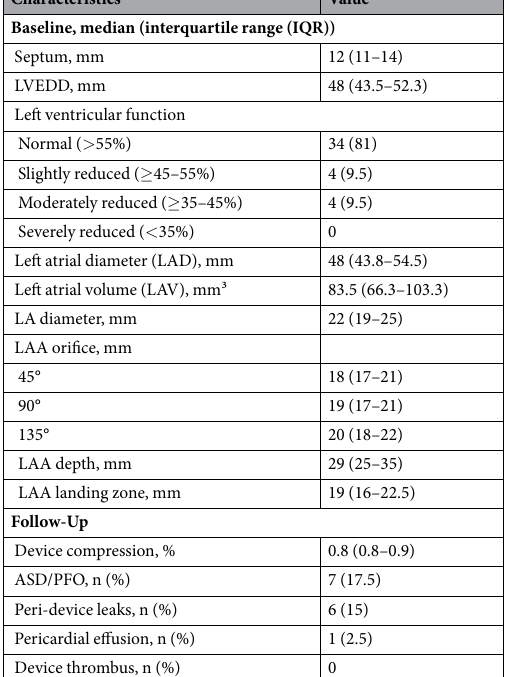
Table 3. Trans-esophageal echocardiography data at baseline (T1) and follow-up (T2). LA = left atrium, LAA = left atrial appendage, LVEDD = left ventricuar end diastolic diameter, LVF = left ventricular function, ASD = atrial septal defect, PFO = patent foramen